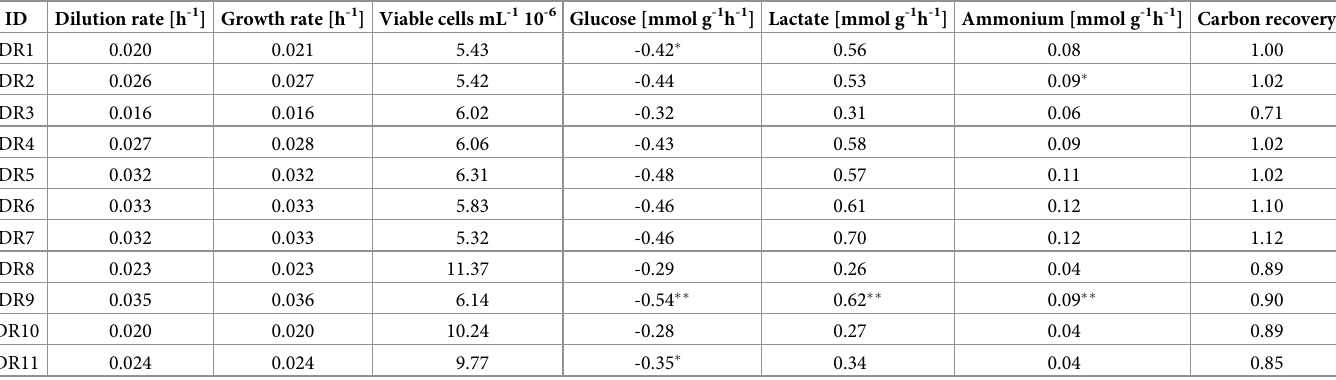
A parameter was considered stable when the 95% confidence interval of the slope from the linear fit contained zero. Carbon recovery was calculated by summing up the total carbon uptake and subtracting the total carbon that is secreted or goes into biomass (based on growth rate and biomass composition from [13]). � The slope was statistically significant, but the change in concentration of glucose and ammonium was within the measurement error of the Bioprofile analyzer. �� Confidence intervals could not be calculated because only two data points were available. The change in concentration was within the measurement error of the Bioprofile